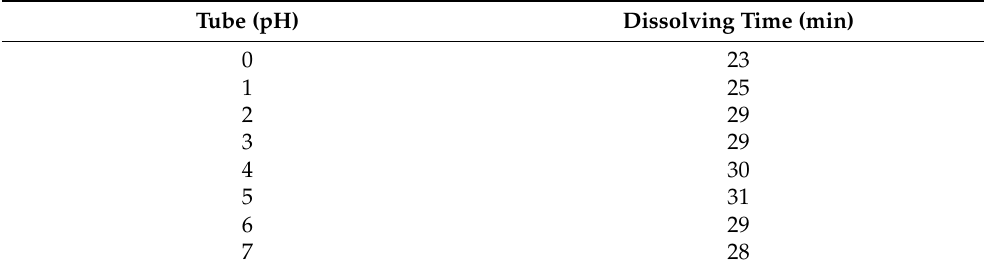
Table 3. Time taken for the capsules to completely dissolve at various pH values. Tube